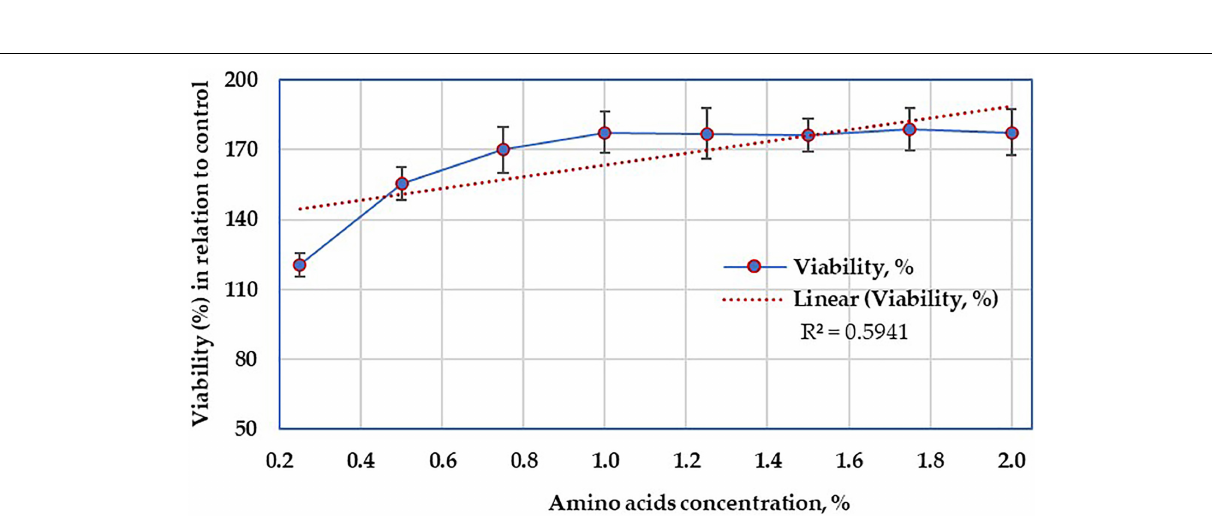
Frontiers in Microbiology |